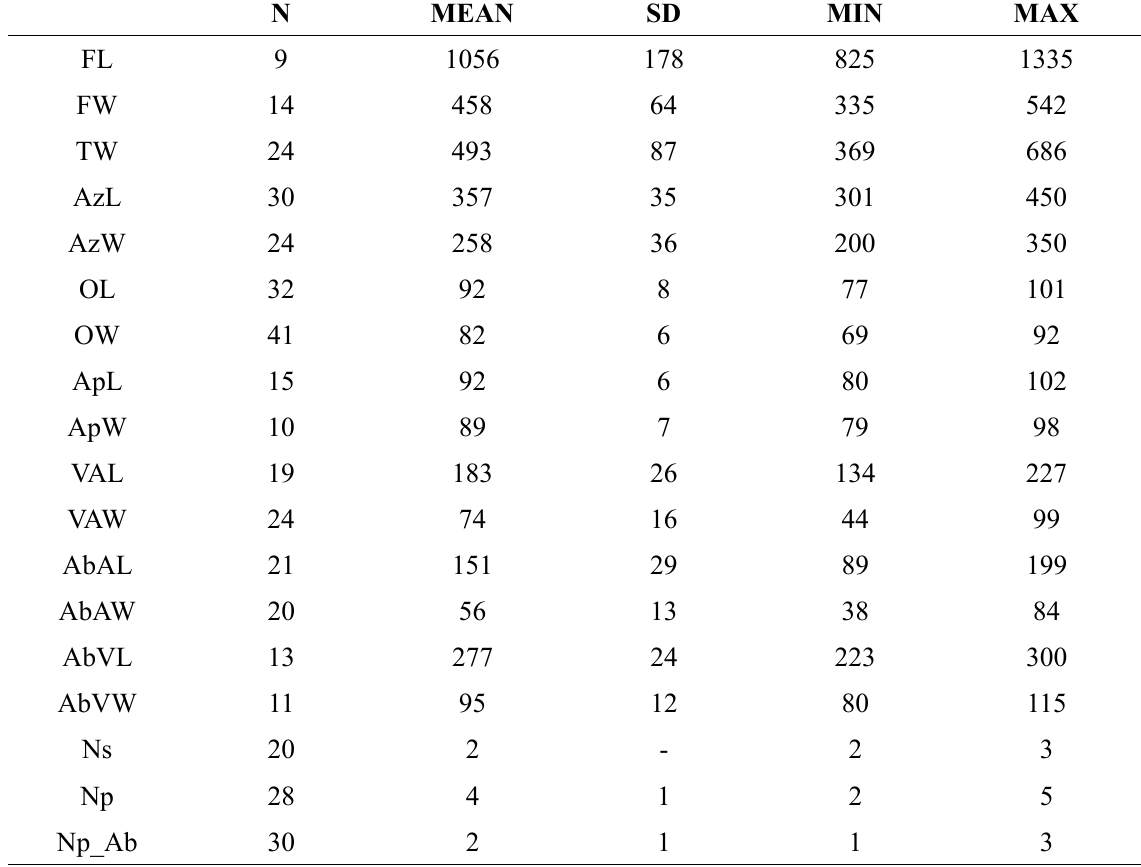
Table 6. Measurements of Schizoretepora sp. nov.? (= S. imperati sensu O’Donoghue & de Watteville